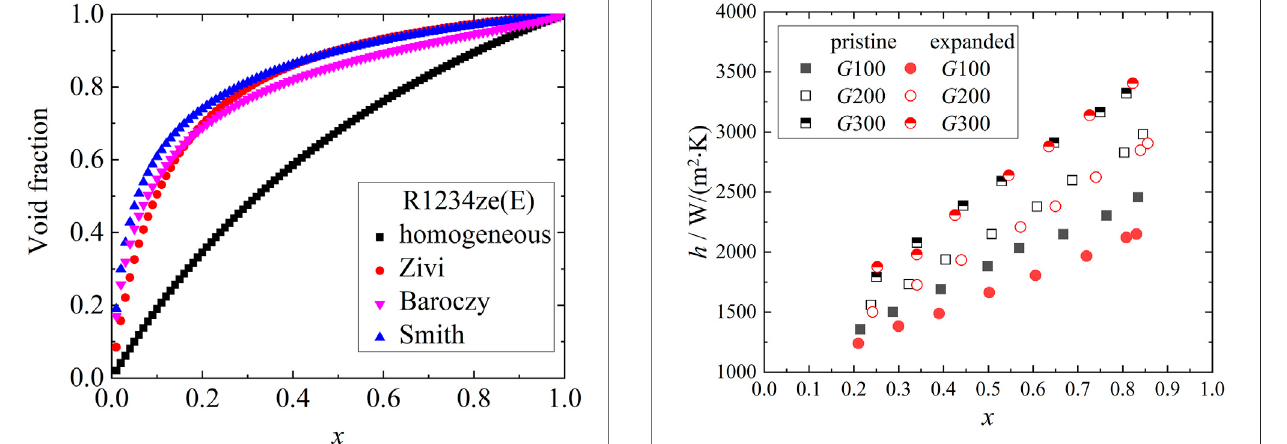
FIGURE 4 | Comparison of void fraction between different models.